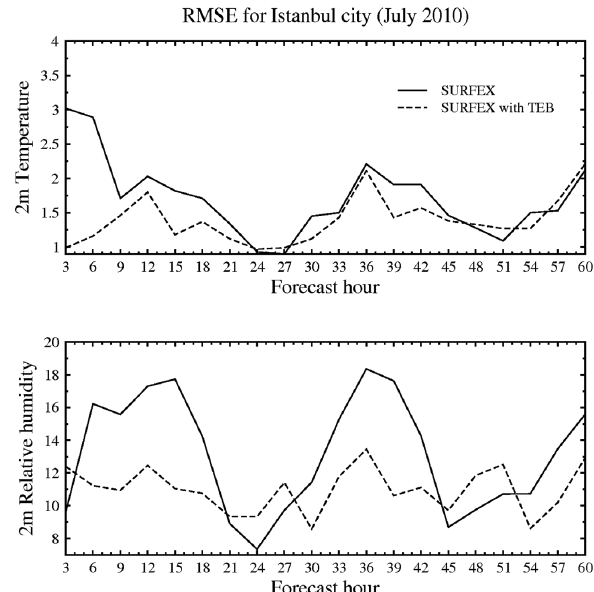
Fig. 11. Rmse of 2m temperature (top) and 2m relative humidity (bottom) against observations at the Istanbul city station averaged over July 2010 for ALARO with SURFEX (solid line) and ALARO with SURFEX and TEB (dashed